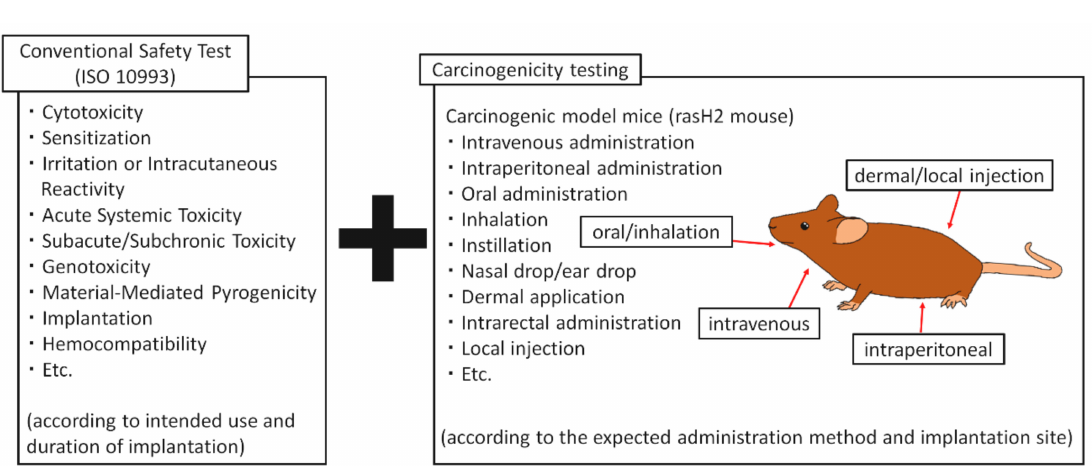
Figure 7. Bio-safety testing of nano-sized biomaterials. Carcinogenicity tests are carried out by using carcinogenic model mice, in addition to conventional safety tests according to the intended application and implantation period of each biomaterial according to ISO 10993-1. The method of administration is selected according to the expected administration method of nano-biomaterials to humans and the implantation